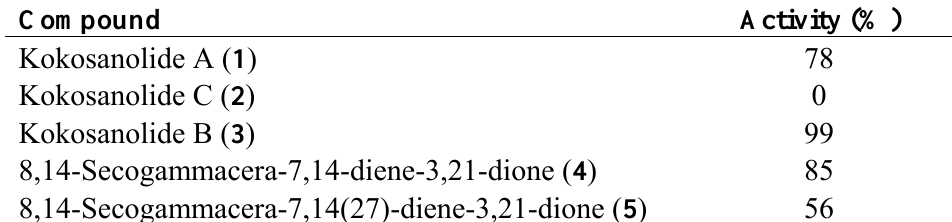
Table 3. Antifeedant activity of compounds 1 – 5